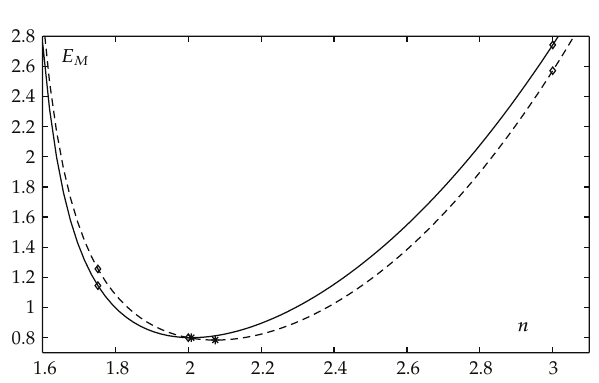
Figure 2: E M (cid:3) n (cid:4) for the fixed temperature boundary condition, for HBIM (cid:3) solid line (cid:4) and RIM (cid:3) dashed line (cid:4) : errors for n (cid:8) 1 . 752 , 2 , 3 are shown as diamonds and the minimum errors are shown as